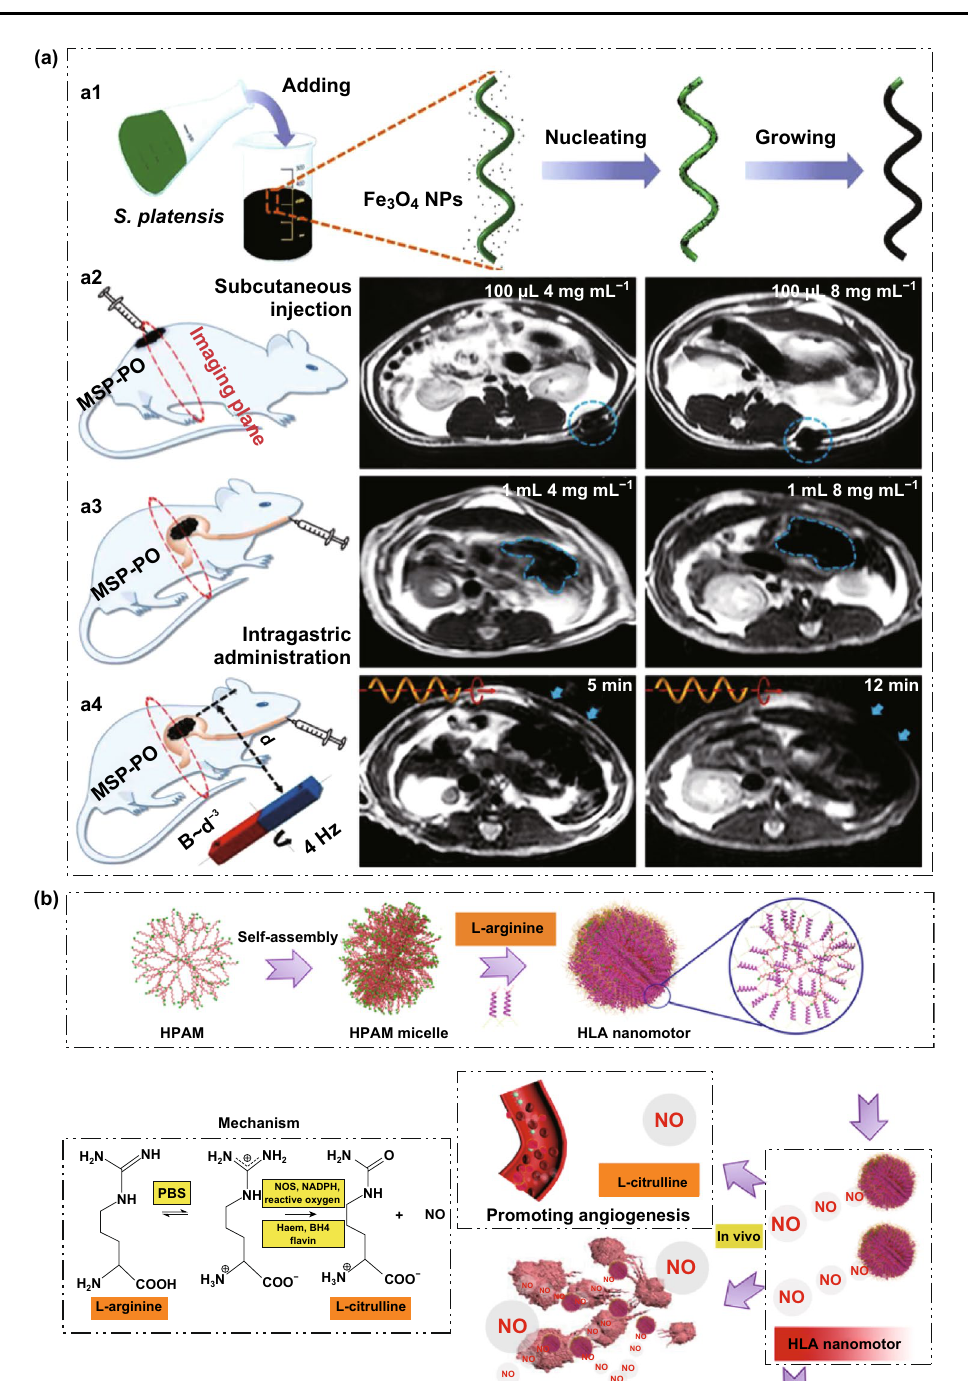
Fig. 7 a ( a1 ) Schematic of the dip-coating process of S. Platensis in a suspension of Fe 3 O 4 NPs. a2 MSP swarm of two different concentrations inside the subcutaneous tissues. a3 MSP swarm of two different concentrations inside the stomachs. a4 MSP swarm with the same concentra- tion but subject to actuation and steering (with a rotating magnetic field) of different time periods before MR imaging across the rat’s stomach. Adapted from [96] with permission, copyright from American Association for the Advancement of Science, 2017. b Schematic illustration of the formation of zwitterion-based nanomotor and the NO generation principle. Adapted from Ref. [97] with permission, copyright American Chemical Society,